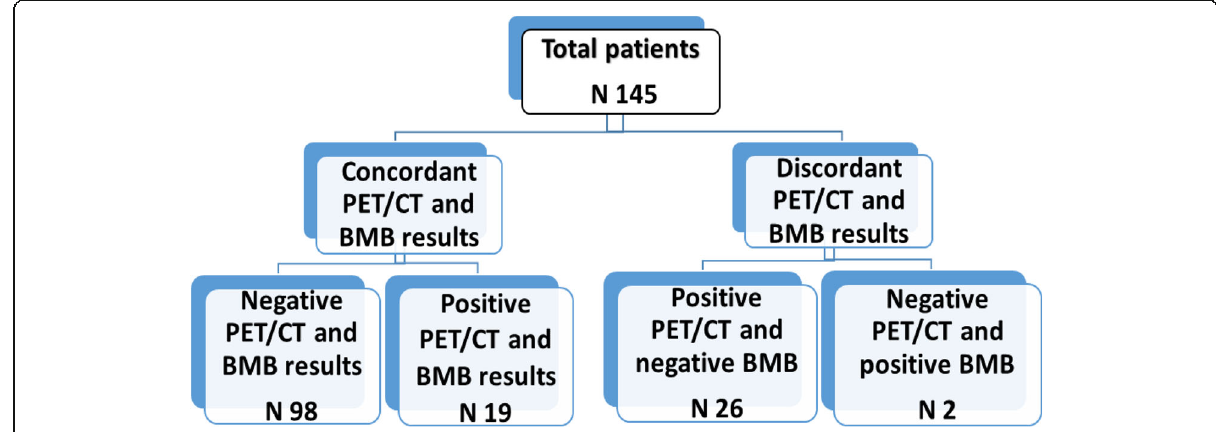
Fig. 5 Concordance/discordance between PET/CT and BMB in detection of BMI